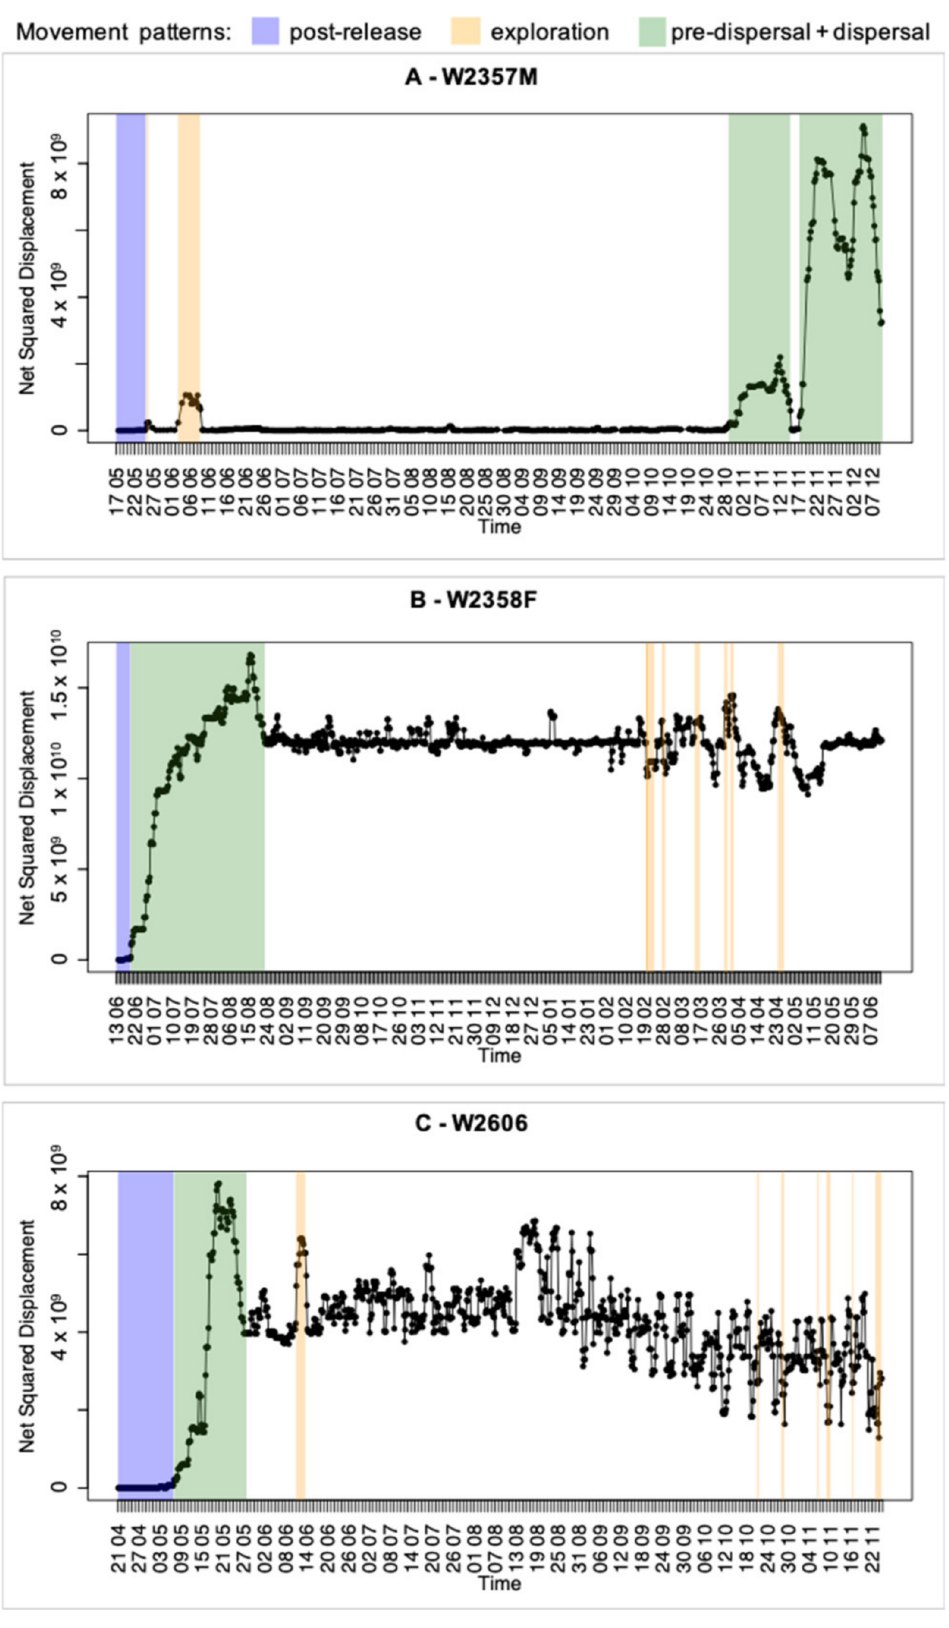
Figure 3. Net squared displacement and identified movement patterns of three GPS-collared wolves in Northern Italy, 2019–2021. ( A ) W2357M; ( B ) W2358F; ( C )